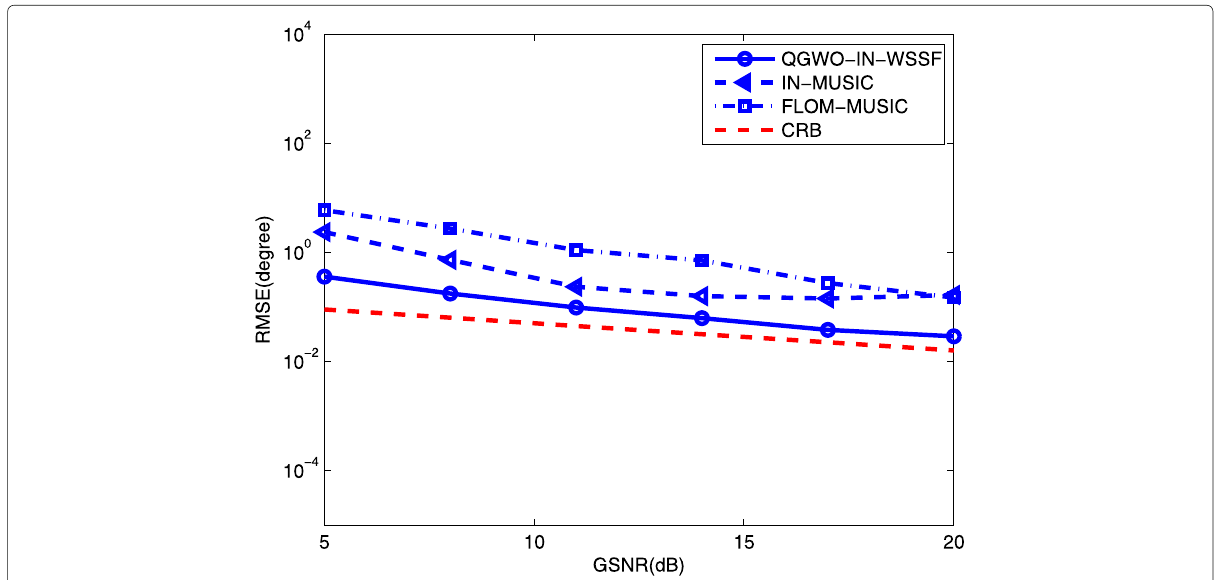
Fig. 6 RMSE curves and CRB versus GSNR for two different independent sources with α =